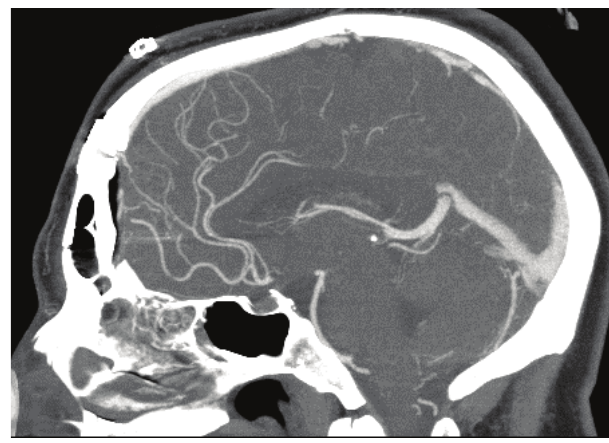
Figure 2. Postoperative computerized tomographic angiography showing normal perfusion of both ophthalmic artery and vein,